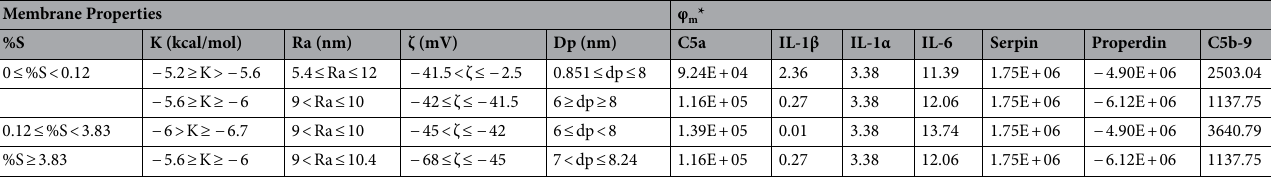
Table 2. The new correction factors were added to the original models (Boxes 1, 2, 3, 4, and 5). For instance, the affinity-based model in Box 5 becomes the new model in Box 7 (Eqs. 49–56). The affinity to FB (K) of different membrane materials (CTA, PAES, PAN, PVDF, PVDF-ZW) was obtained using molecular docking (Fig. S3), with values listed in Table S2. Importantly, these expanded models for different materials were developed based on incubation experiments, and therefore the equations must be evaluated at Qb = 0 and t = 30 min. When using material correction factors ( ϕ M ), the equations predict the release of biomarkers in the absence of flow. The two correction factors cannot be used in combination due to the distinct nature of each one.